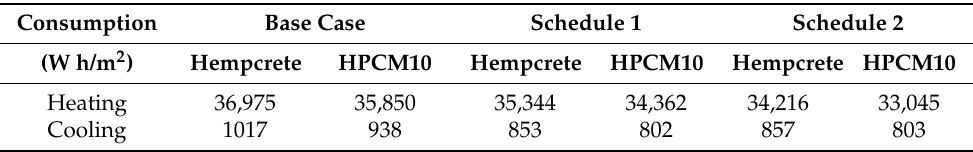
Table 4. Annual energy consumption under BC, SCH1, and SCH2.